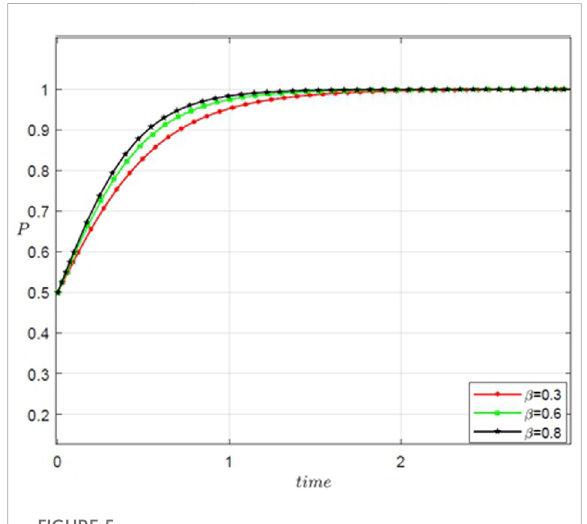
FIGURE 5 The effect of extra cost ( β ) on the evolution of ECSNs when both parties cooperate